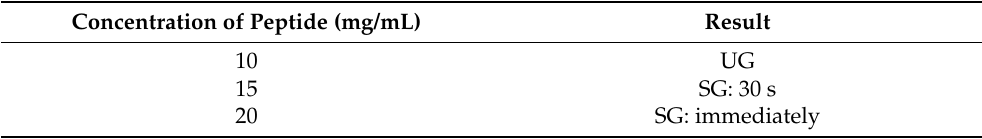
Table 1. Gelation of OE peptides at different concentrations.